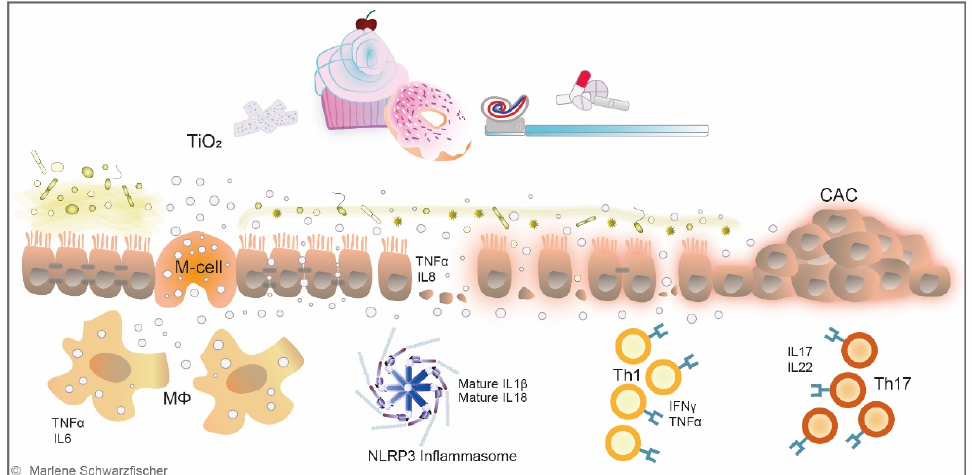
Figure 2. TiO 2 —impact on gut homeostasis. Food-grade titanium dioxide (TiO 2 ) nanoparticles are omnipresent in the Western diet. Ingested TiO 2 nanoparticles can enter the system through microfold cells (M-cells), paracellular transport through epithelial cells or penetration through epithelial lesions. In the gut, TiO 2 exposure negatively affects microbiota diversity/composition and has adverse impacts on barrier integrity via reduction in mucus secretion, modulation of tight junctions, and induction of pro-inflammatory cytokine expression in enterocytes. TiO 2 nanoparticles accumulate in phagocytic macrophages (M φ ), promoting pro-inflammatory response. Furthermore, TiO 2 nanoparticles activate the NLRP3 inflammasome in epithelial and immune cells, triggering pro- inflammatory signaling cascades. TiO 2 exposure induces clonal expansion of T-helper (Th1/Th17) cells in the lamina propria, which exert pro-inflammatory functions and are closely associated with IBD pathogenesis. Together, these events promote chronic epithelial lesions and intestinal inflammation, resulting in an elevated risk of developing colitis-associated colon carcinoma